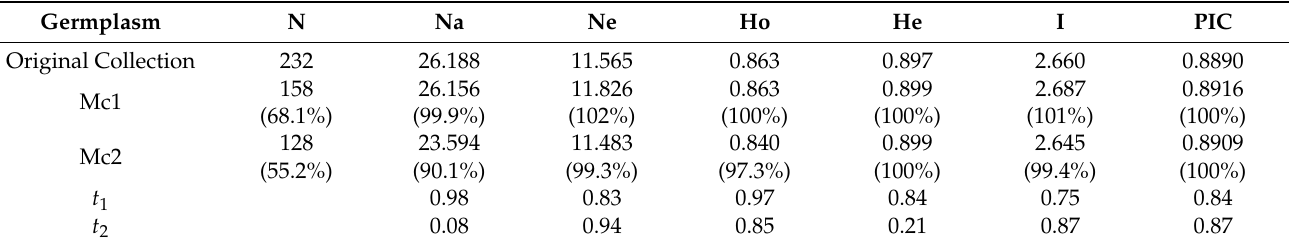
Table 7. Results of the t -test for the diversity parameters of the core and original collections.